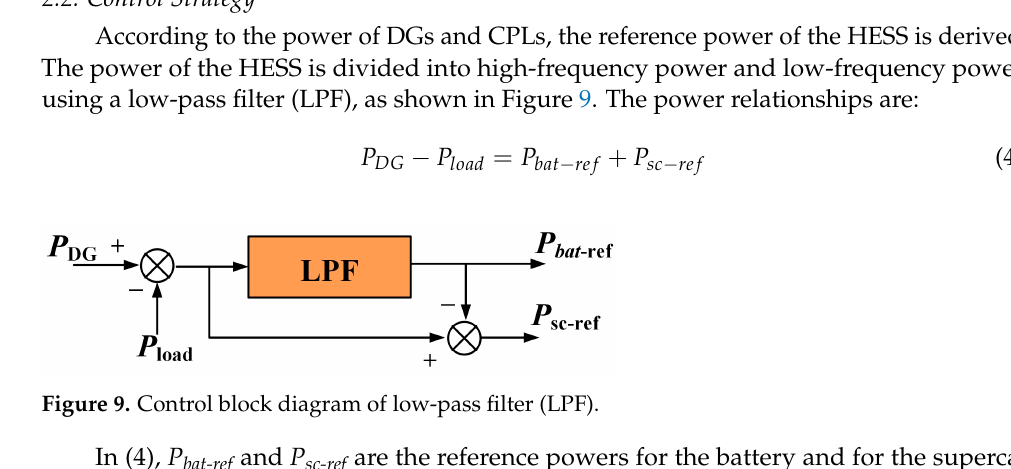
6 of 21 Figure 8. Nonlinear model of a DC microgrid. In Figure 8, v bat is the battery voltage, i bat is the battery current, R 1 is the equivalent internal resistance of the battery, L 1 is the inductance of the bidirectional DC/DC